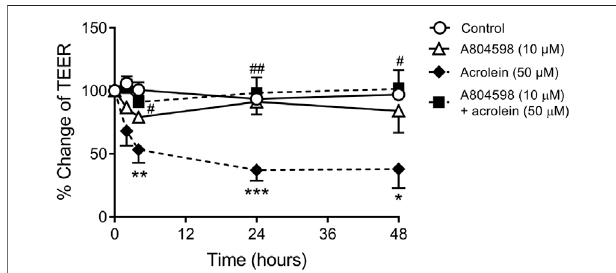
FIGURE 4 | Effect of P2X7R inhibition on acrolein-induced disruption to urothelial cell integrity measured by TEER. Data were expressed as the percentage change of TEER relative to pre-treatment of the same well. Two- way ANOVA analysis showed a highly signi fi cant reduction in TEER after urothelial cells were treated with acrolein (50 µM) up to 48 h (**** p < 0.0001 compared to control). Acrolein induced TEER reduction was signi fi cantly prevented by co-incubation with P2X7R antagonist A804598 (10 µM) ( ##### p < 0.0001 compared to acrolein alone). A804598 alone did not show any effect on TEER values. Each condition wasmeasured as duplicates of n = 8 animals. Two-way ANOVA followed by Bonferroni ’ s multiple comparison